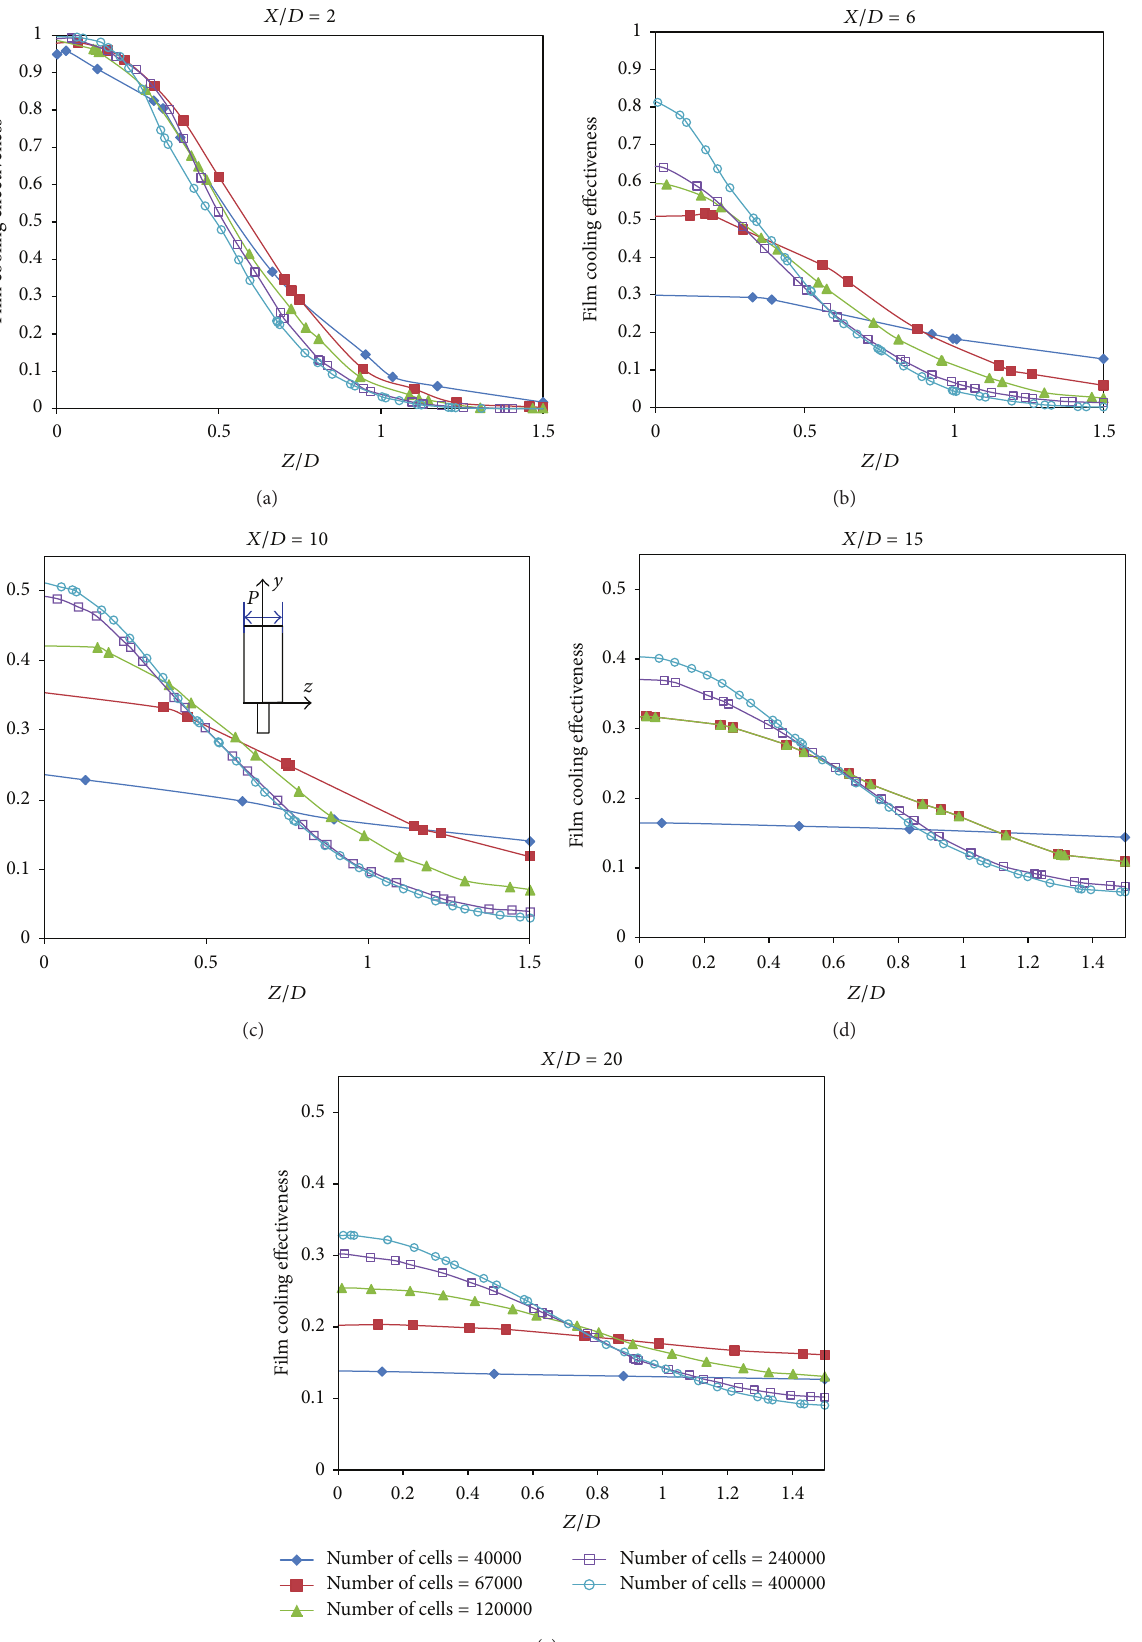
Figure 12: Variation of the local film cooling effectiveness with the spanwise direction for LFDSA-5-5 hole, streamwise angle 30deg, and 𝑀=1